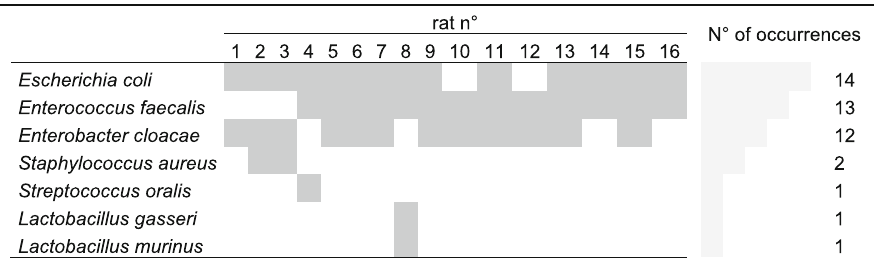
Table 1 Blood culture analysis of 16 rats 16 h after CLP